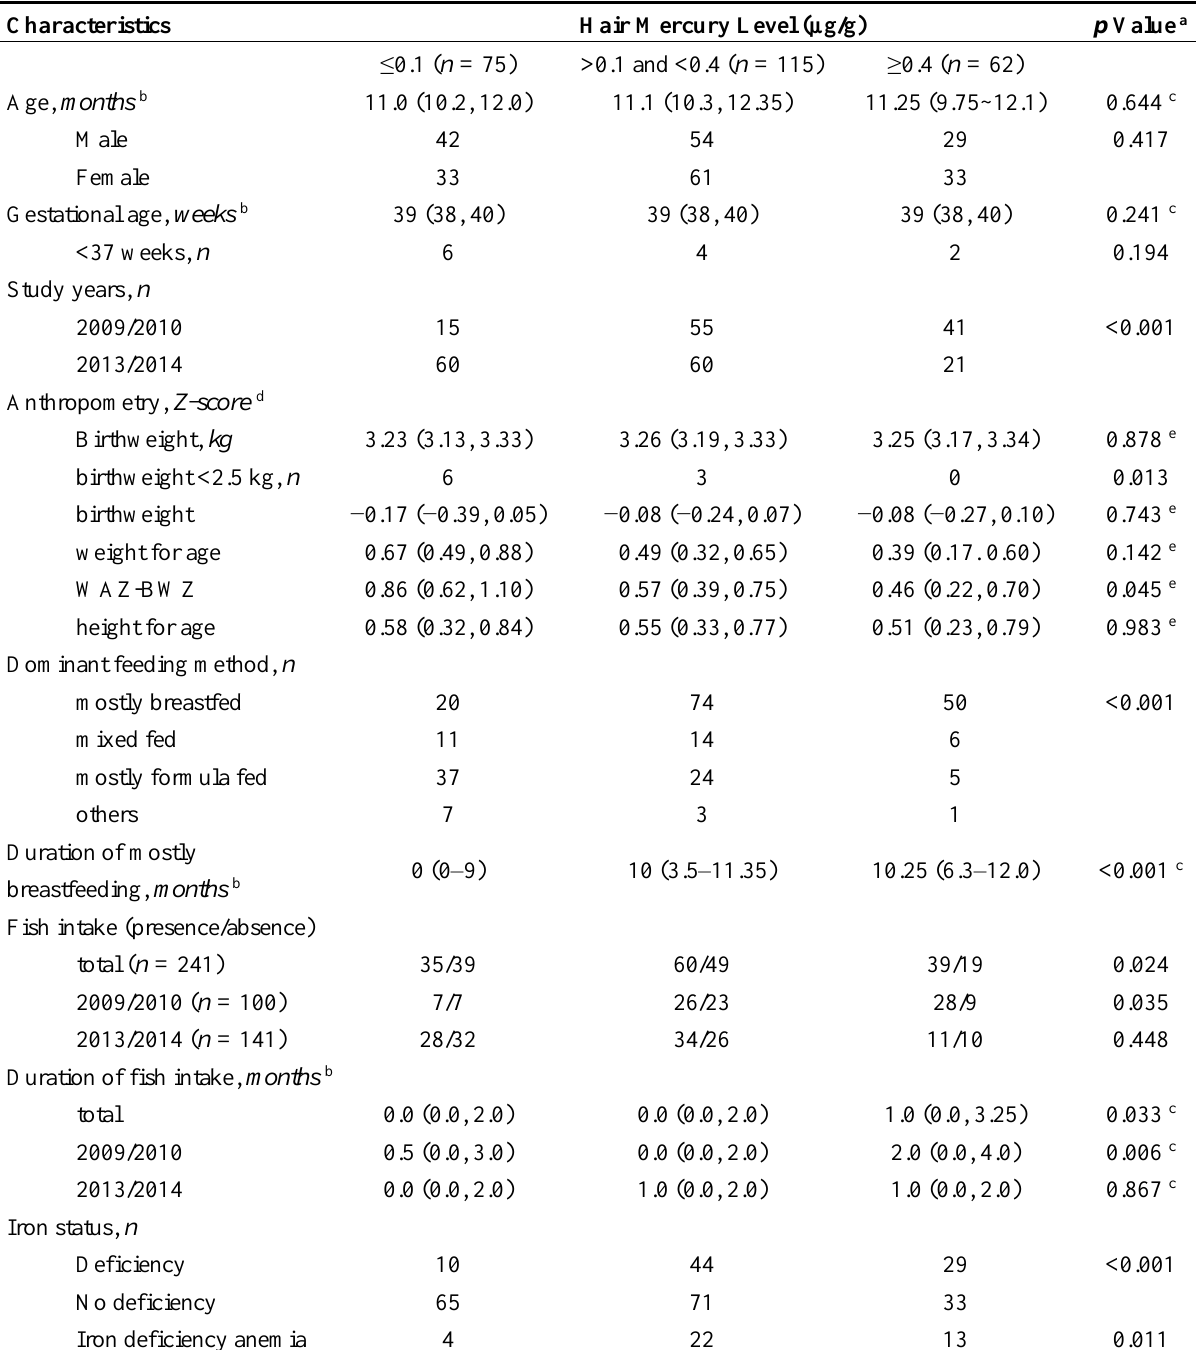
Table 3. Demographic, anthropometric, and diet-related parameters and iron status in three categories of infants according to the quartile values of hair mercury